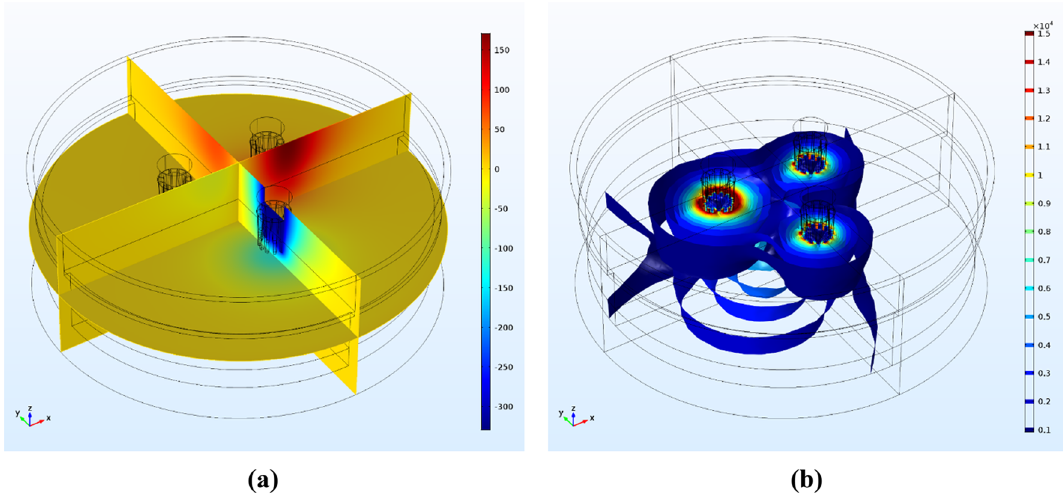
Figure 1. ( a ) Electric potential distribution (V) in the SAF extracted from a frame at 0.02 s. The minimum and maximum electric potential values are detected within the electrode core and a strong decay to ground values (0 V) is observed and ( b ) Current density isosurfaces (A/m 2 ) at the time frame of 0.015 s. In comparison to the electric potential values, the current density is observed in both slag and ferronickel